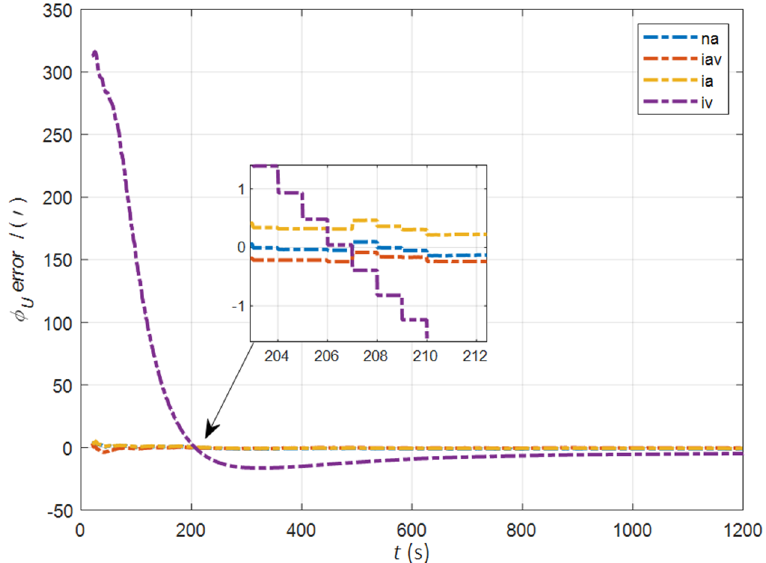
φ in the cases of the initial misalignment angles T [5 5 20 ] N